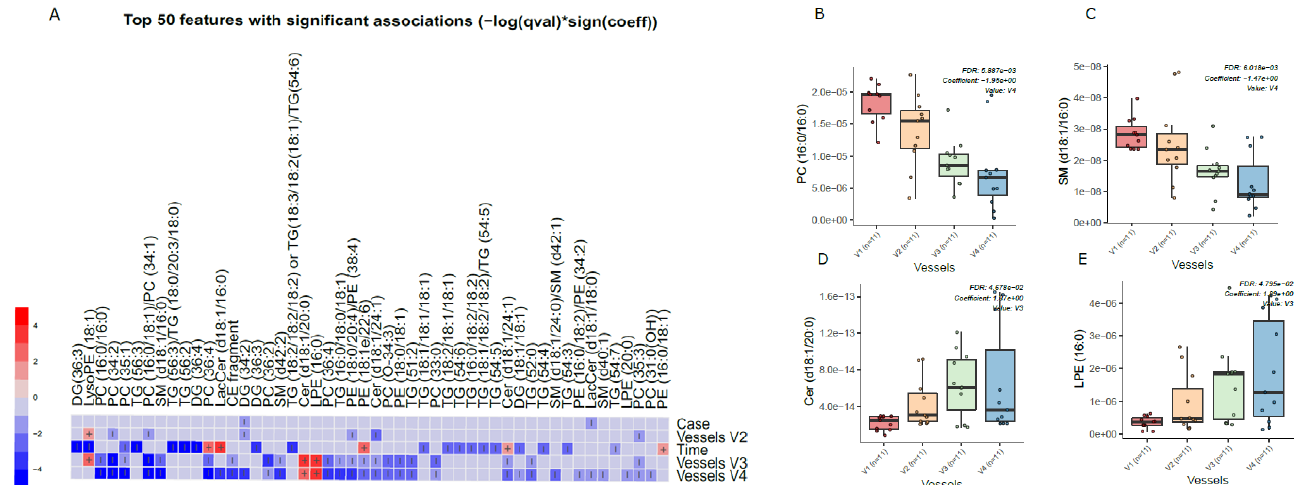
Figure 2. Dynamics of lipids in the in vitro colon simulator. The figure depicts the lipidomic changes in four vessels (V1–V4) over two time points (24 and 48 h). ( A ) Heat map showing the difference in